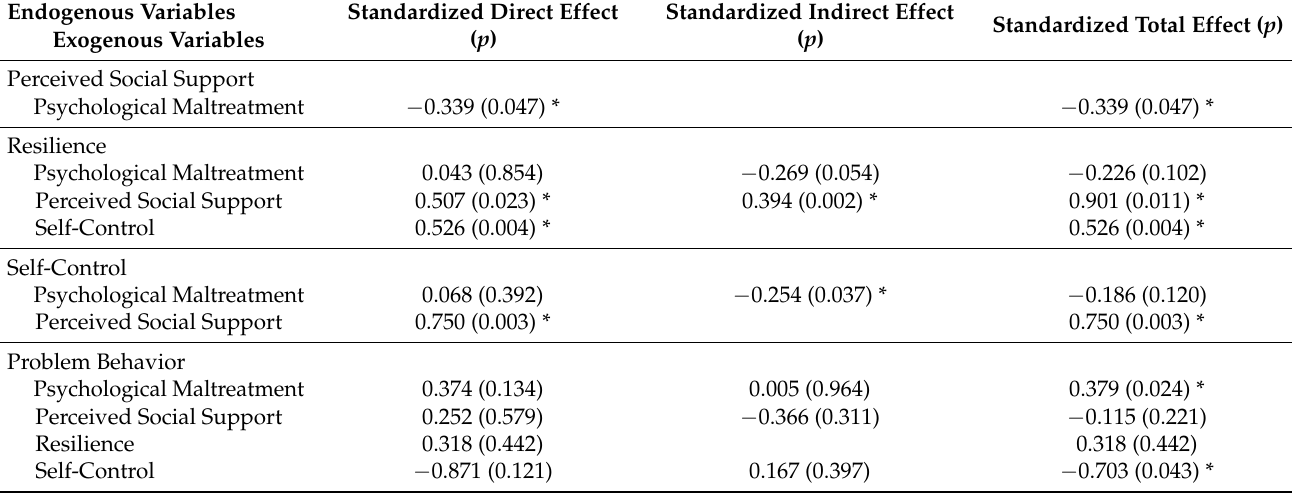
Table 7. Direct, Indirect, and Total Effect of the Hypothetical